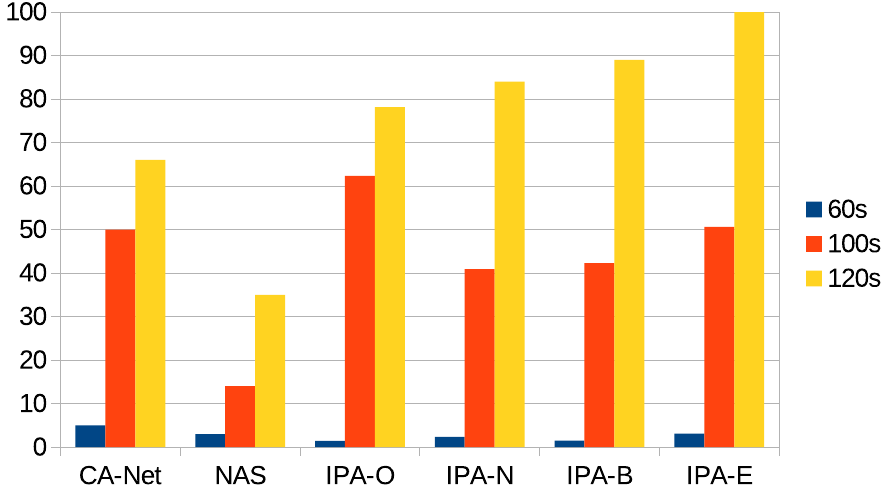
Figure 5. Percentage of successfully executed jobs for each deadline, out of the submitted